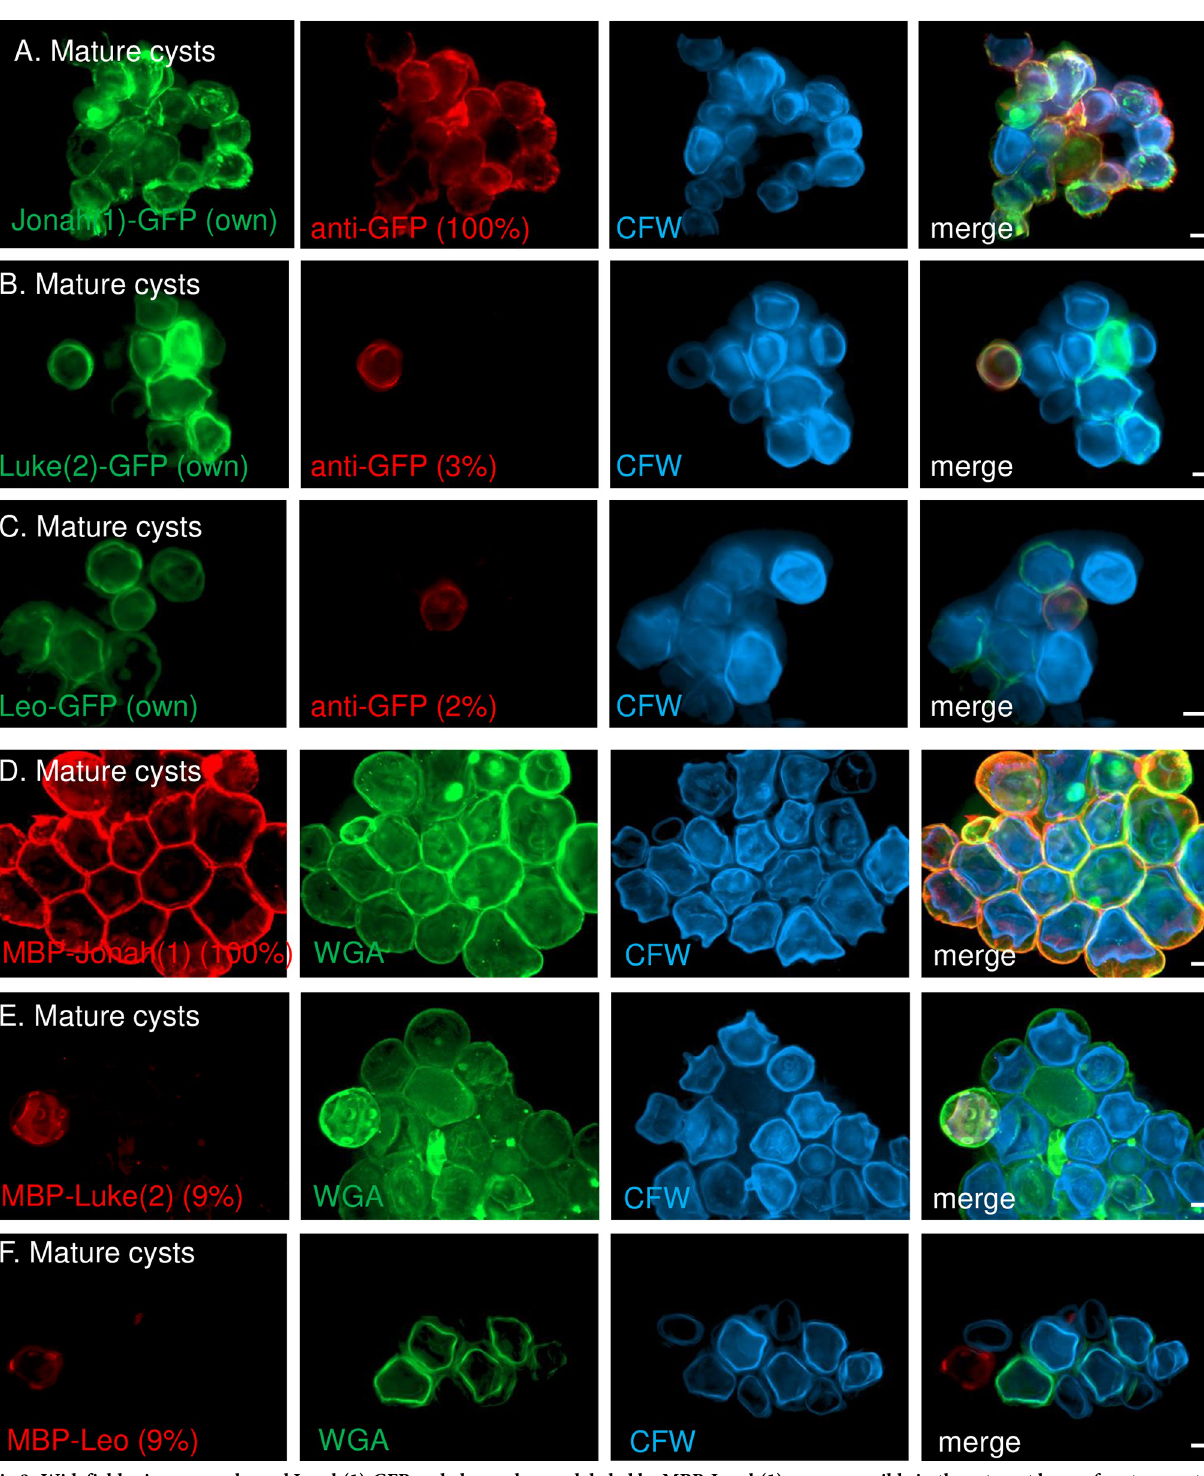
Fig 9. Widefield microscopy showed Jonah(1)-GFP and glycopolymers labeled by MBP-Jonah(1) were accessible in the ectocyst layer of mature cyst walls, while Luke(2)-GFP, Leo-GFP, and glycopolymers labeled by MBP-Luke(2) and MBP-Leo were inaccessible in the endocyst layer and ostioles. A. Nearly 100% of mature cysts expressing Jonah(1)-GFP (green) under its own promoter were labeled with anti-GFP antibodies (red). CFW (blue) labeled the endocyst layer of cyst walls. B. Just 3% of mature cysts expressing Luke(2)-GFP under its own promoter labeled with anti-GFP antibodies. C. Just 2% of mature cysts expressing Leo-GFP under its own promoter labeled with anti-GFP antibodies. D. MBP-Jonah(1) (red) labeled 100% of mature cysts, which